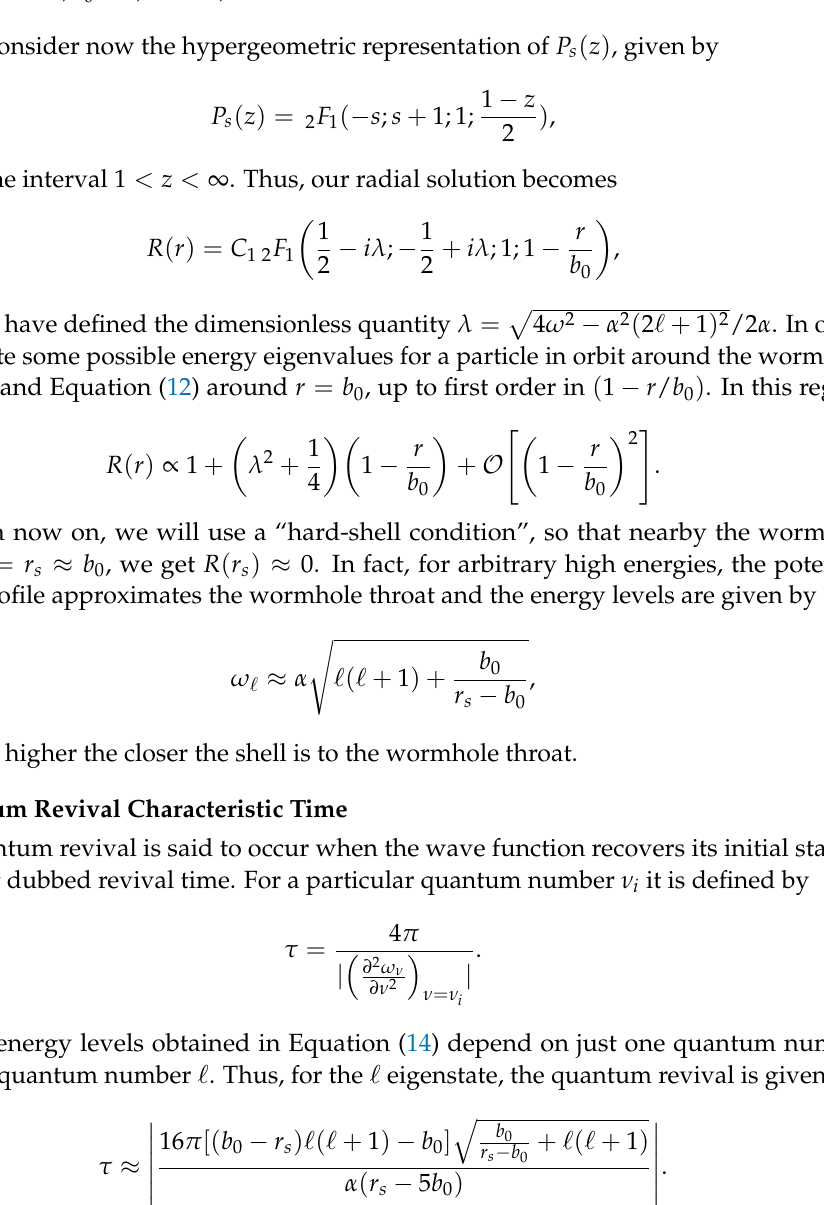
Figure 2. Radial part of the massless scalar field around the deformed Rindler–Schwarzschild wormhole, in terms of the radial coordinate ( left ), and tortoise coordinate ( right ). The parameter settings are (cid:96) = 1, b 0 = 1, α = 0.5, and ω = 10 in Planck